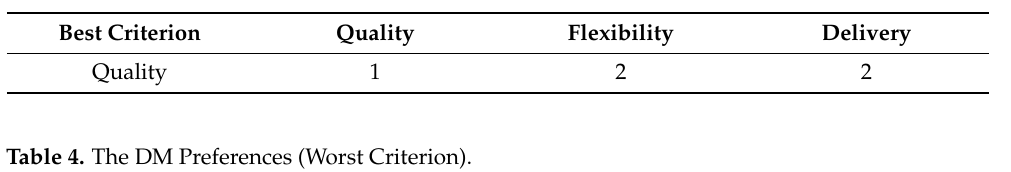
Table 3. The DM Preferences (Best Criterion).